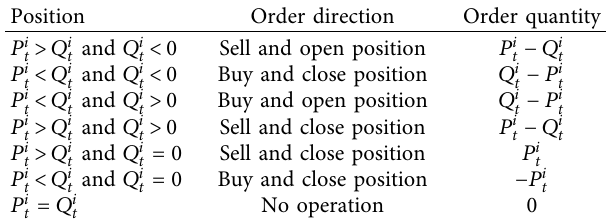
Table 5: Order placing rules for hedgers. Position Order direction Order